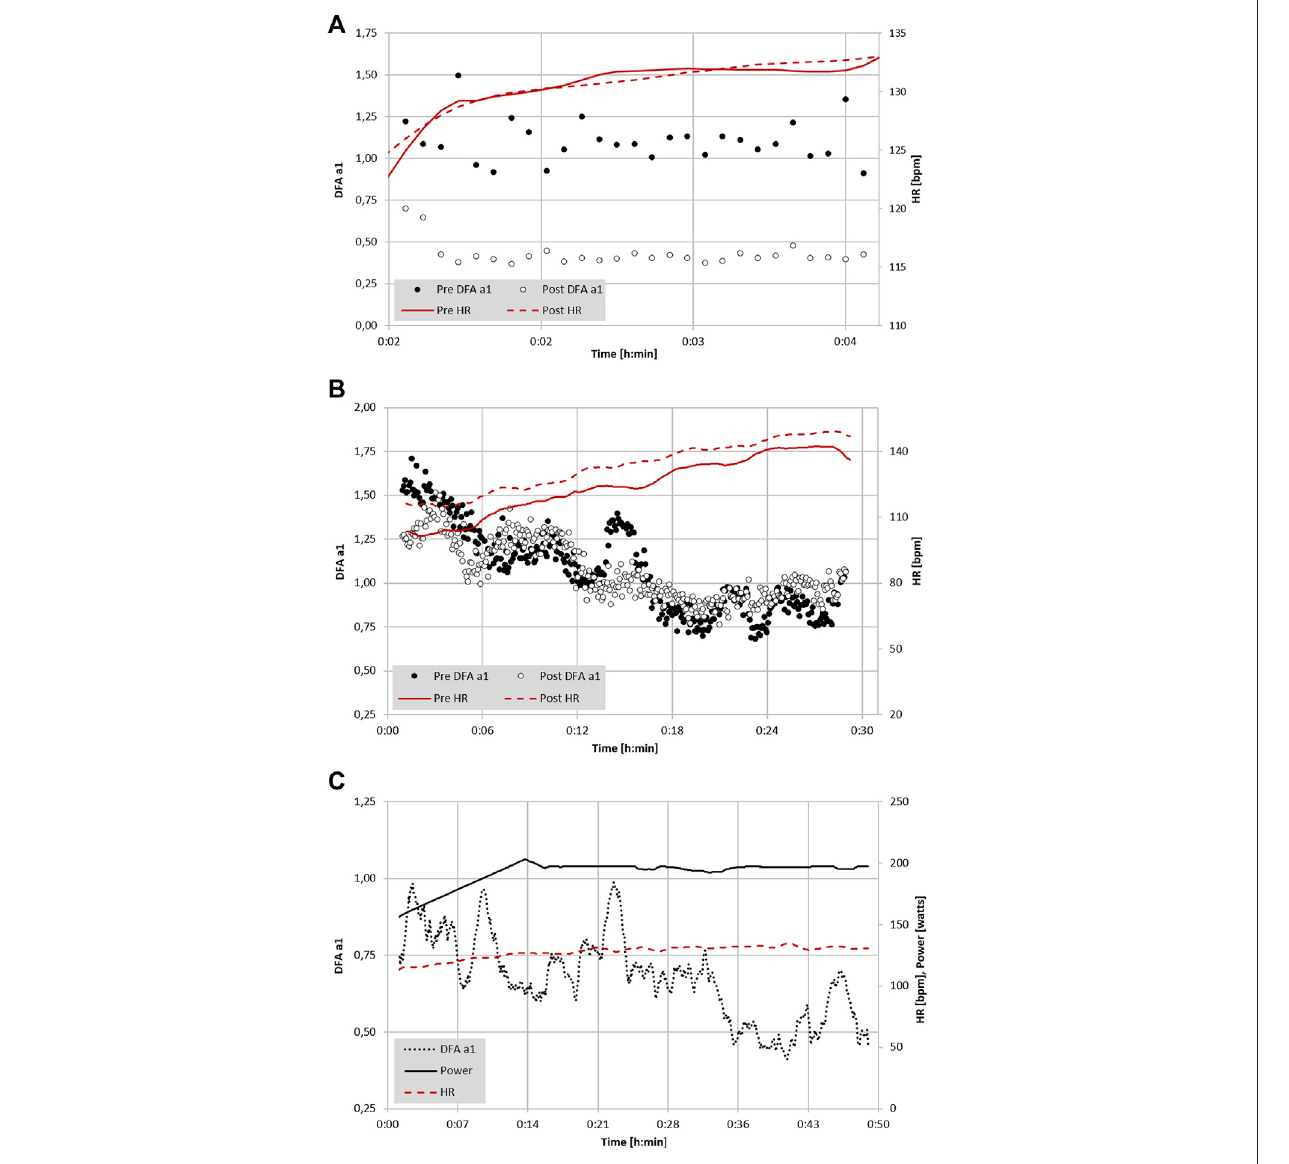
FIGURE2|(A) AnalysisofDFAa1andHRofa22-year-oldmaleparticipantwithaVO 2MAX of74 ml/kg/minduringa5-mintreadmilltestat65%ofVT1(VO 2 )before and immediately following a 6-h continuous trail run (data adapted from Rogers et al., 2021e). (B) Analysis of DFA a1, power and HR of a 41-year-old former Olympic male triathlete with a VO 2MAX of 65 ml/kg/min performing 6-min progressive cycling intervals of 100, 130, 160, 190, 220 W before and immediately after 2 h of continuous cycling exercise at 65% LT1 power (adapted from Gronwald et al., 2021). (C) Analysis of DFA a1 and HR of a 48-year-old male participant with a VO 2MAX of46 ml/kg/minduring15 kmcyclingexerciseat90%ofVT1(VO 2 )(unpublisheddata).AlldatarecordedwithaPolarH10chestbelt(PolarElectroOy,Kempele, Finland)and analyzedwithKubiosHRV Premium softwareVersion3.5 ( “ time varying ” option: window width of2 min, grid interval of5 s); lines represent4points moving